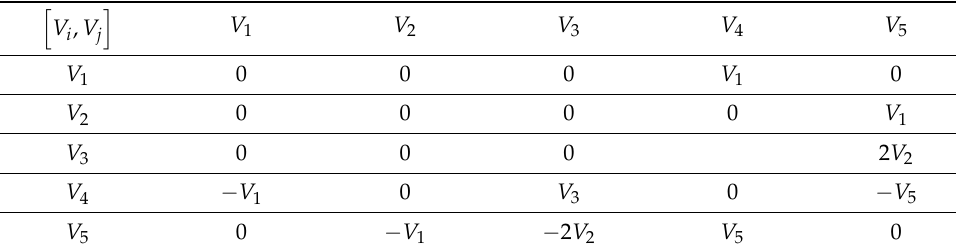
Table 1. Commutator table of